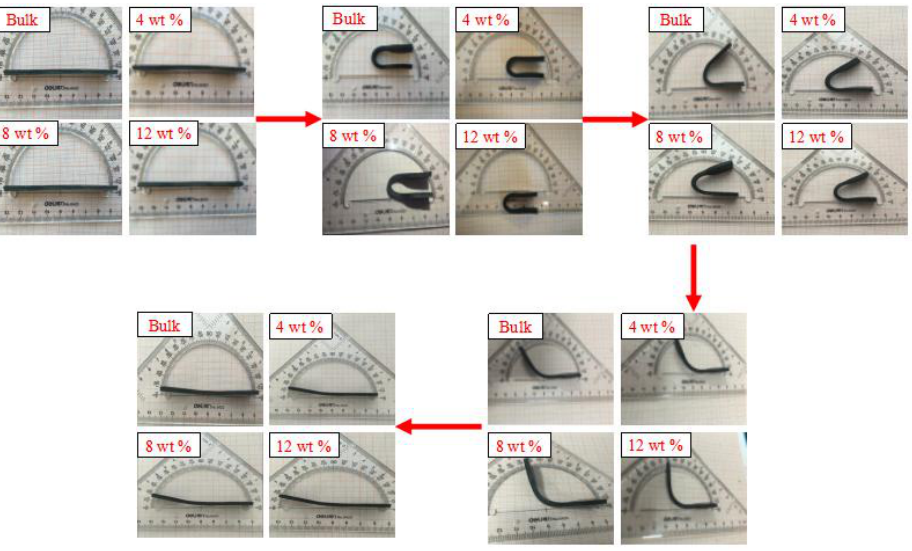
Figure 17. Process for the test of shape memory properties.